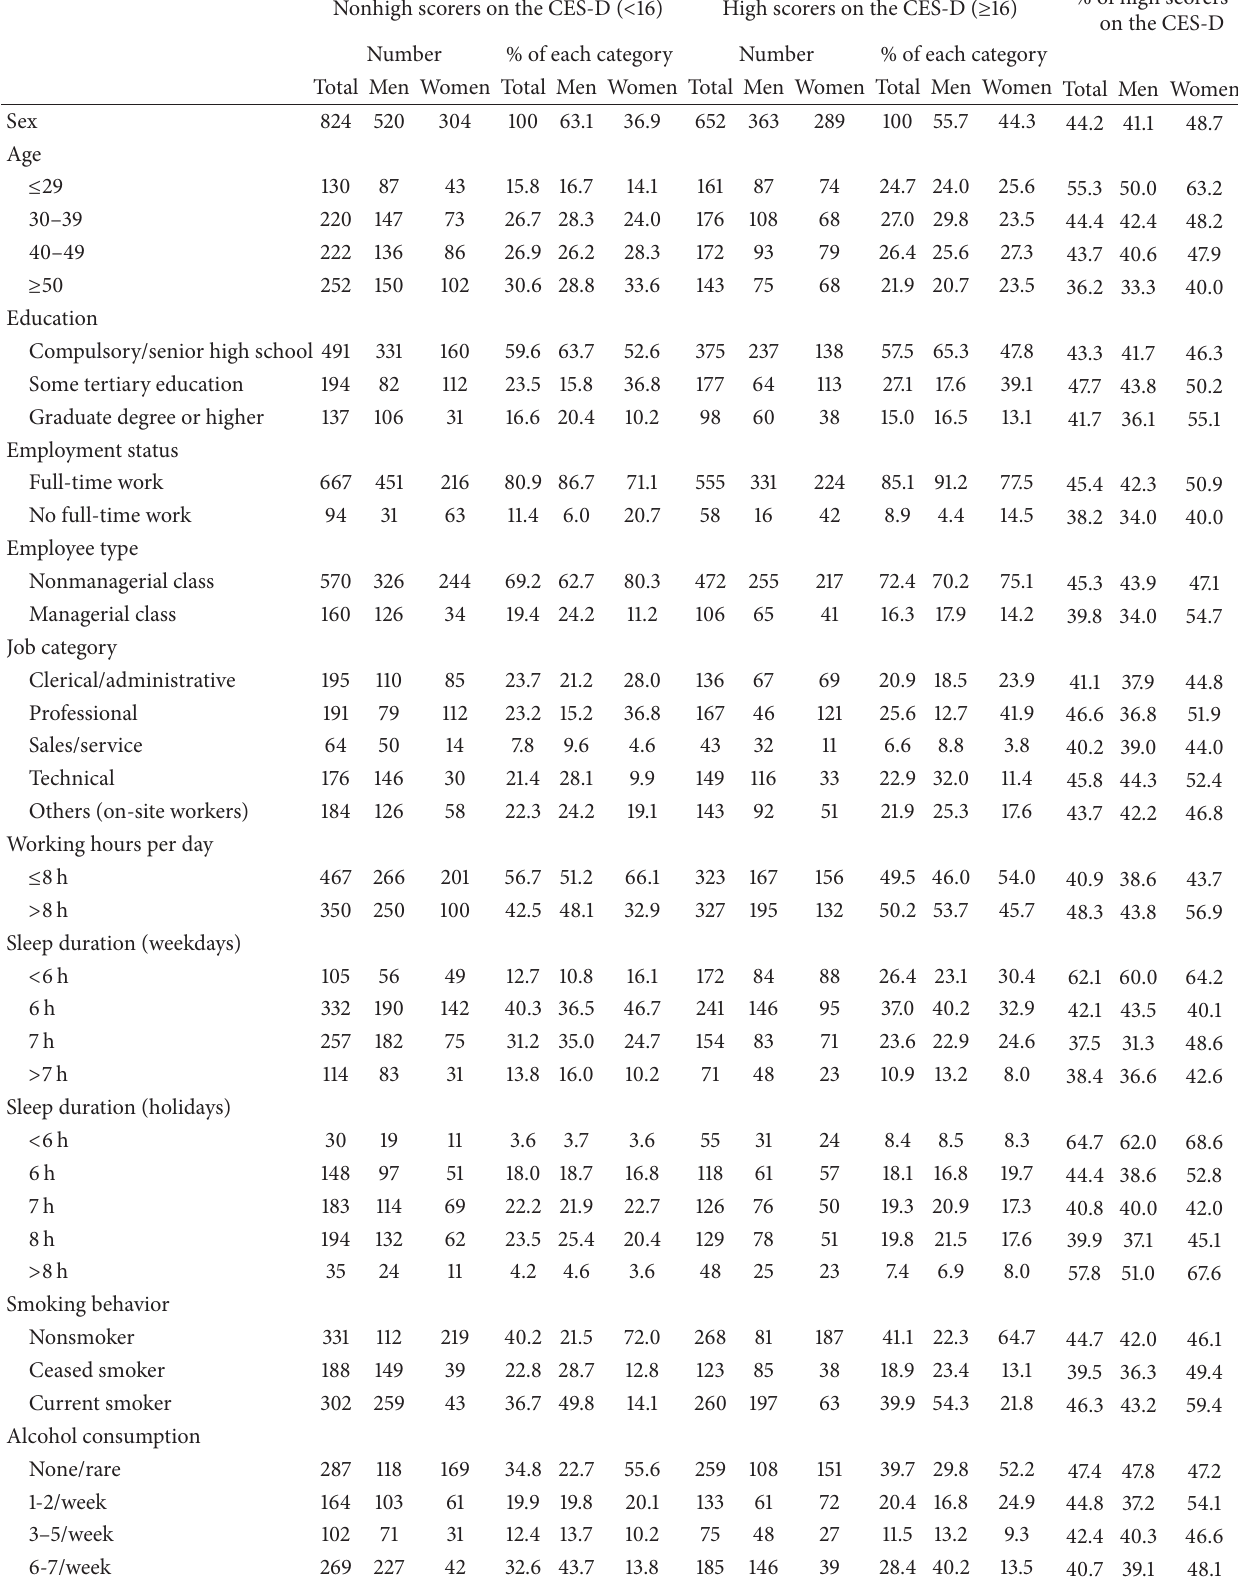
Table 2: Demographics of sample and the comparison between nonhigh scorers on the CES-D ( < 16) and high scorers on the CES-D ( ≥ 16) in the 2010